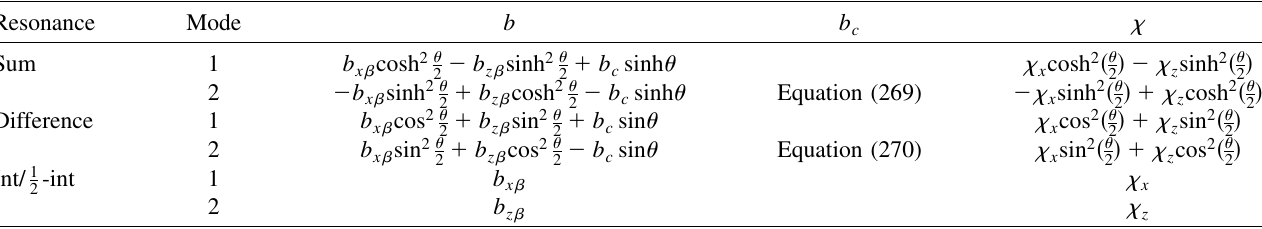
TABLE V. This table contains the damping coefficients near each of the linear resonances. The b column gives the local damping column tells where to find the formula for the extra term b contained in the corresponding local coefficient for modes 1 and 2. The b c c damping coefficient. Finally, the (cid:3) column contains the global damping decrement which is given by integrating the local quantity. The approximations used for these expressions are discussed in the text. The angle (cid:16) is given by tan (cid:1) 1 (cid:2) (cid:4)= (cid:2) (cid:6) (cid:3) for the difference resonance and tanh (cid:1) 1 (cid:2) (cid:4)= (cid:2) (cid:6) (cid:3) for the other resonances where (cid:4) and (cid:2) (cid:6) are given in Table I.